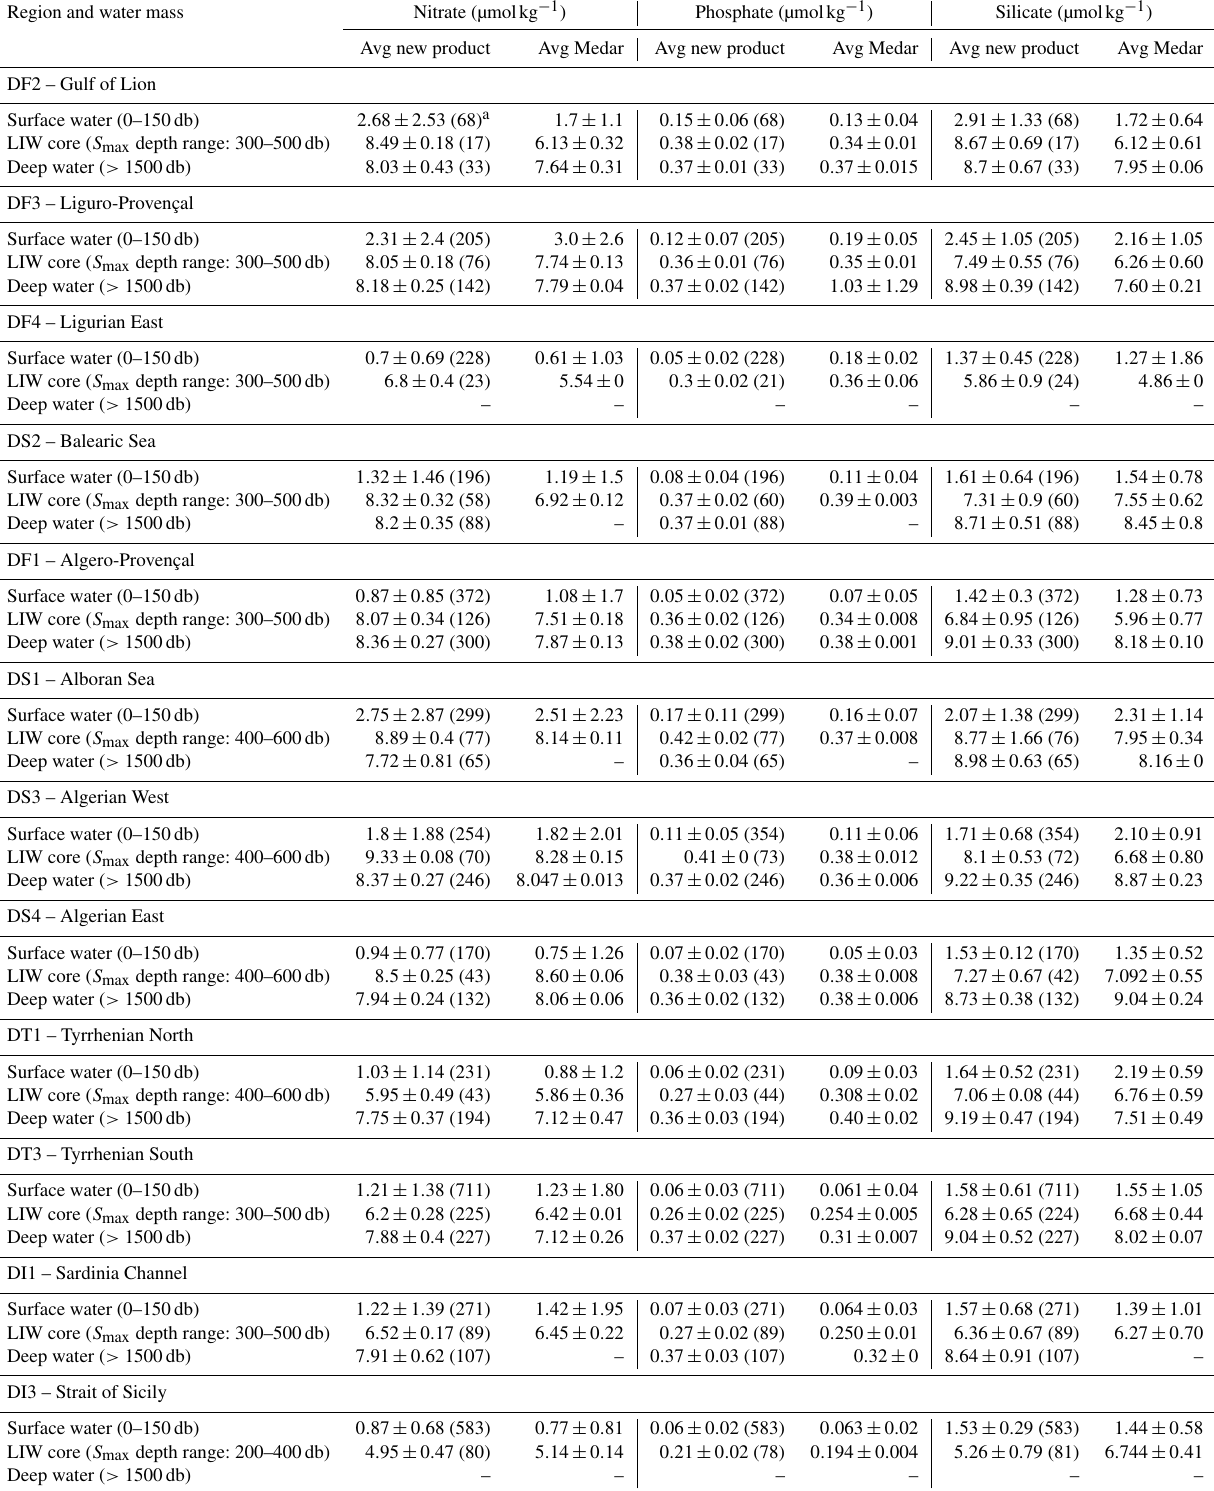
Table 7. Water mass properties and regional average concentrations of inorganic nutrients: comparison between the new adjusted product and the MEDAR/MEDATLAS climatology (with standard deviations and number of observations in brackets). Region and water